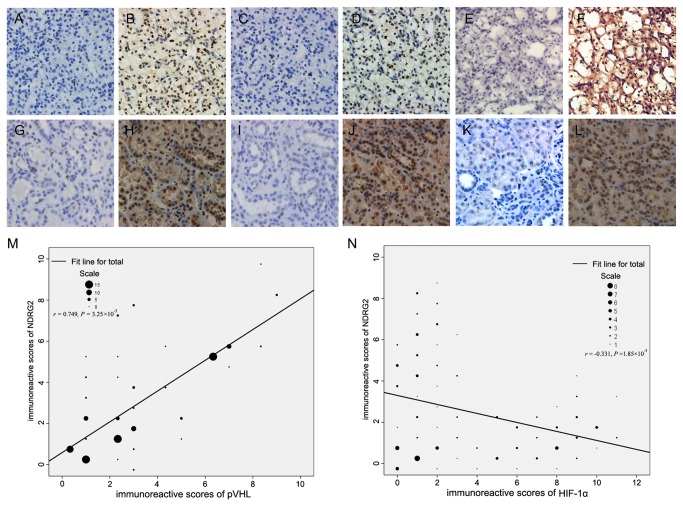
Expression of NDRG2, pVHL and HIF-1α in normal renal tissues and CCRCC tissues.Representative photomicrographs of immunohistochemical staining for NDRG2, pVHL and HIF-1αin normal renal tissues and CCRCC tissues. (A and B) NDRG2 expression in CCRCC tissues (200× magnification). (C and D) pVHL expression in CCRCC tissues (200× magnification). (E and F) HIF-1α expression in CCRCC tissues (200× magnification). (G and H) NDRG2 expression in normal kidney tubules (200× magnification). (I and J) pVHL expression in normal kidney tubules (200× magnification). (K and L) HIF-1αexpression in normal kidney tubules (200× magnification). (M) The expression levels of NDRG2 are positively correlated with those of pVHL. (N) The expression levels of NDRG2 are negatively correlated with those of HIF-1α. The number of specimen was shown as ‘scale’. Disparities across groups were analyzed using Pearson correlation coefficient and the graph was generated by SPSS19.0 software.